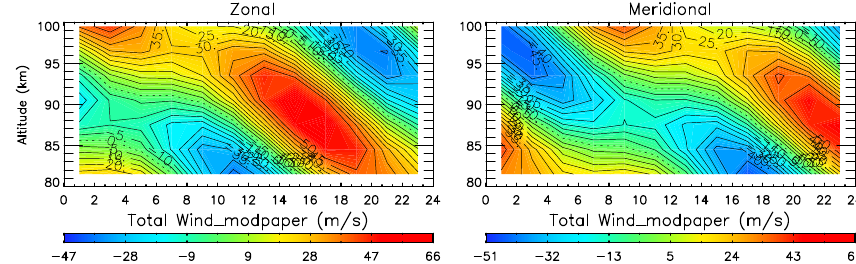
Fig. 8. Total wind velocity used in the model, zonal (left), and meridional (right). Dotted lines indicate zero wind.